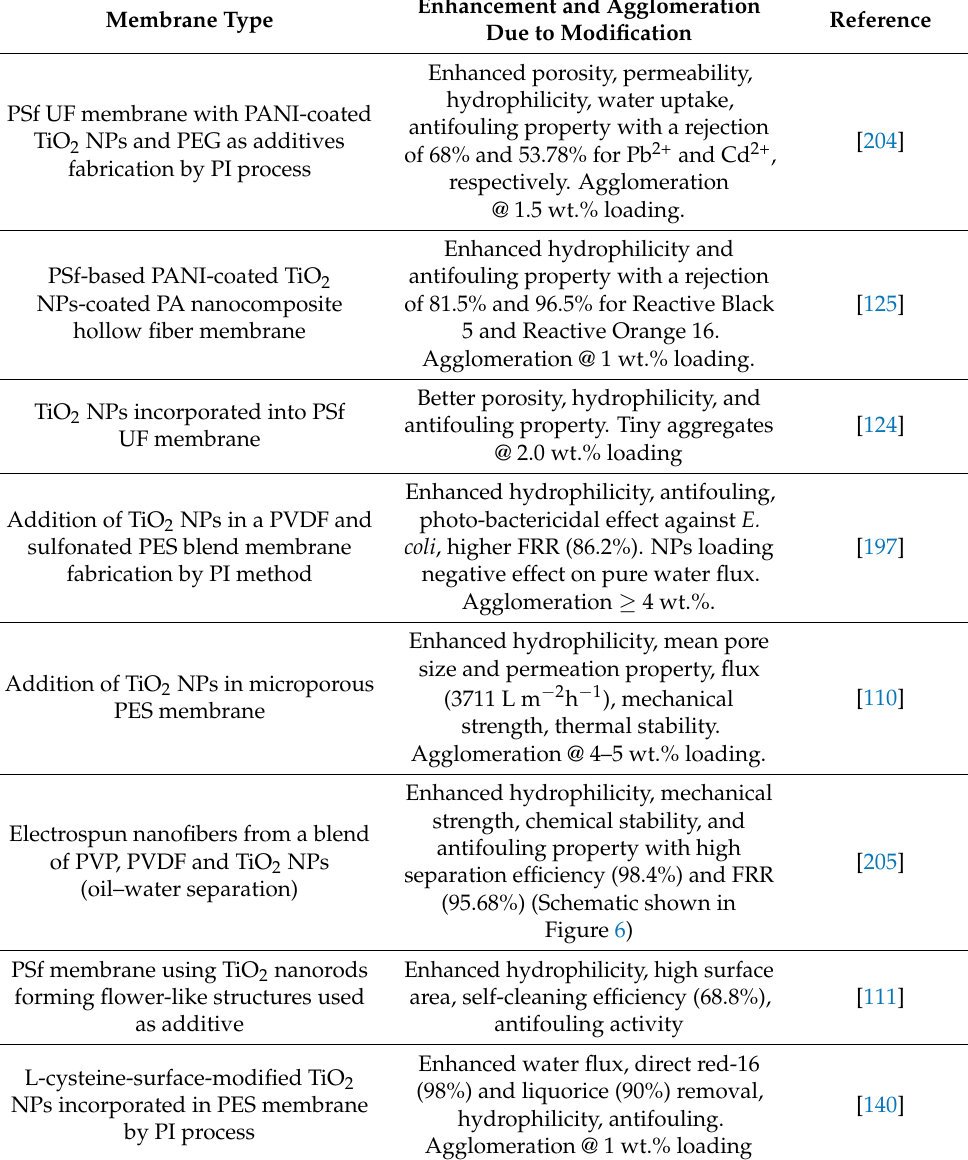
Table 3. A summary of key enhancements in properties of TiO 2 nanoparticle-based nanocomposite